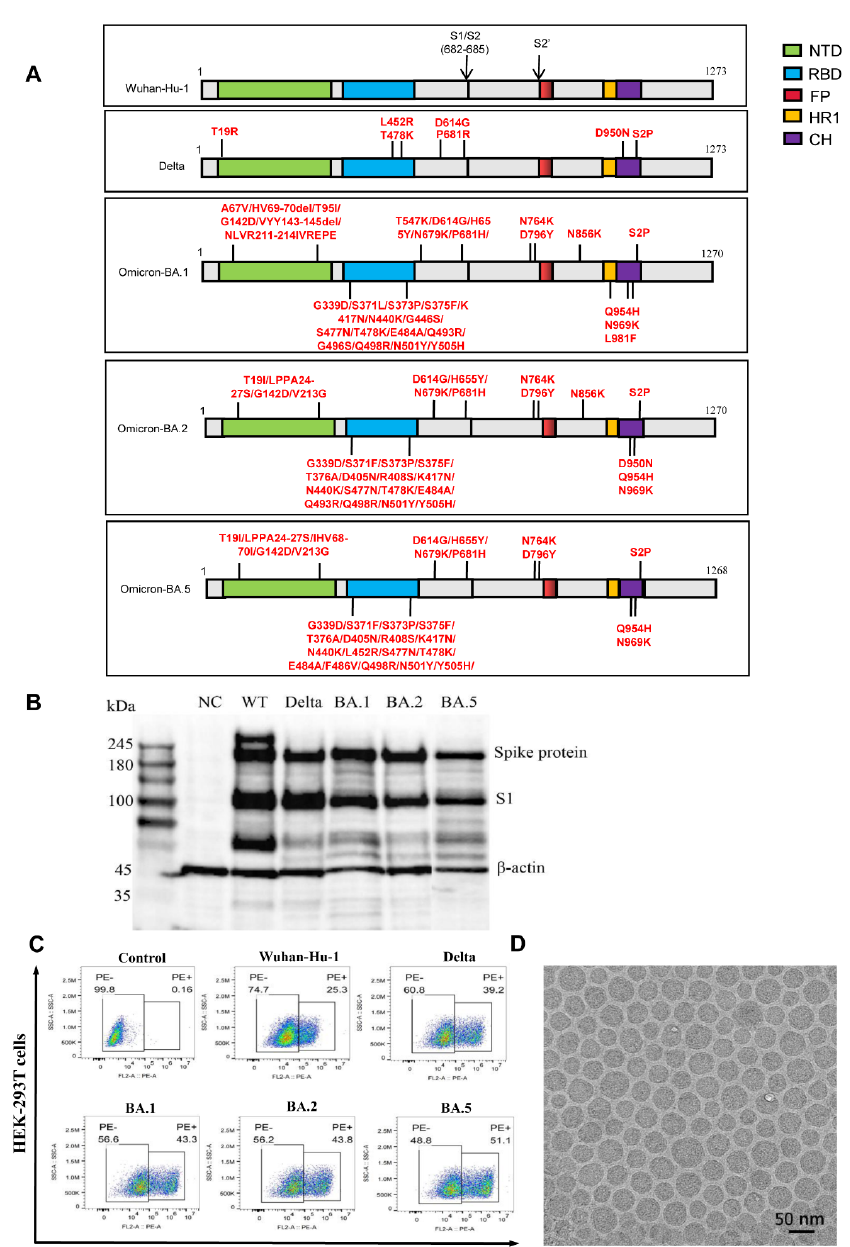
Figure 1. Design and characterization of the mRNA vaccines against different SARS-CoV-2 variants. ( A ) Schematic diagram of the target spike (S) protein-antigen encoded by mRNA vaccines against the Wuhan-Hu-1, Delta, Omicron BA.1, BA.2, and BA.5 variants. The mutation and/or deletion of amino acids are labeled. NTD, N-terminal domain. RBD, receptor-binding domain. FP, fusion peptide. HR1, heptad repeat 1. CH, central helix. ( B ) The expression of the S and S1 proteins in HEK293 cells transfected with IVT mRNA was detected by western blotting. ( C ) HEK293 cells were transfected with IVT mRNA, and hACE2-binding cells were analyzed by flow cytometry. ( D ) Spherical nanoparticles were visualized under a transmission electron microscope. Scale bar, 50